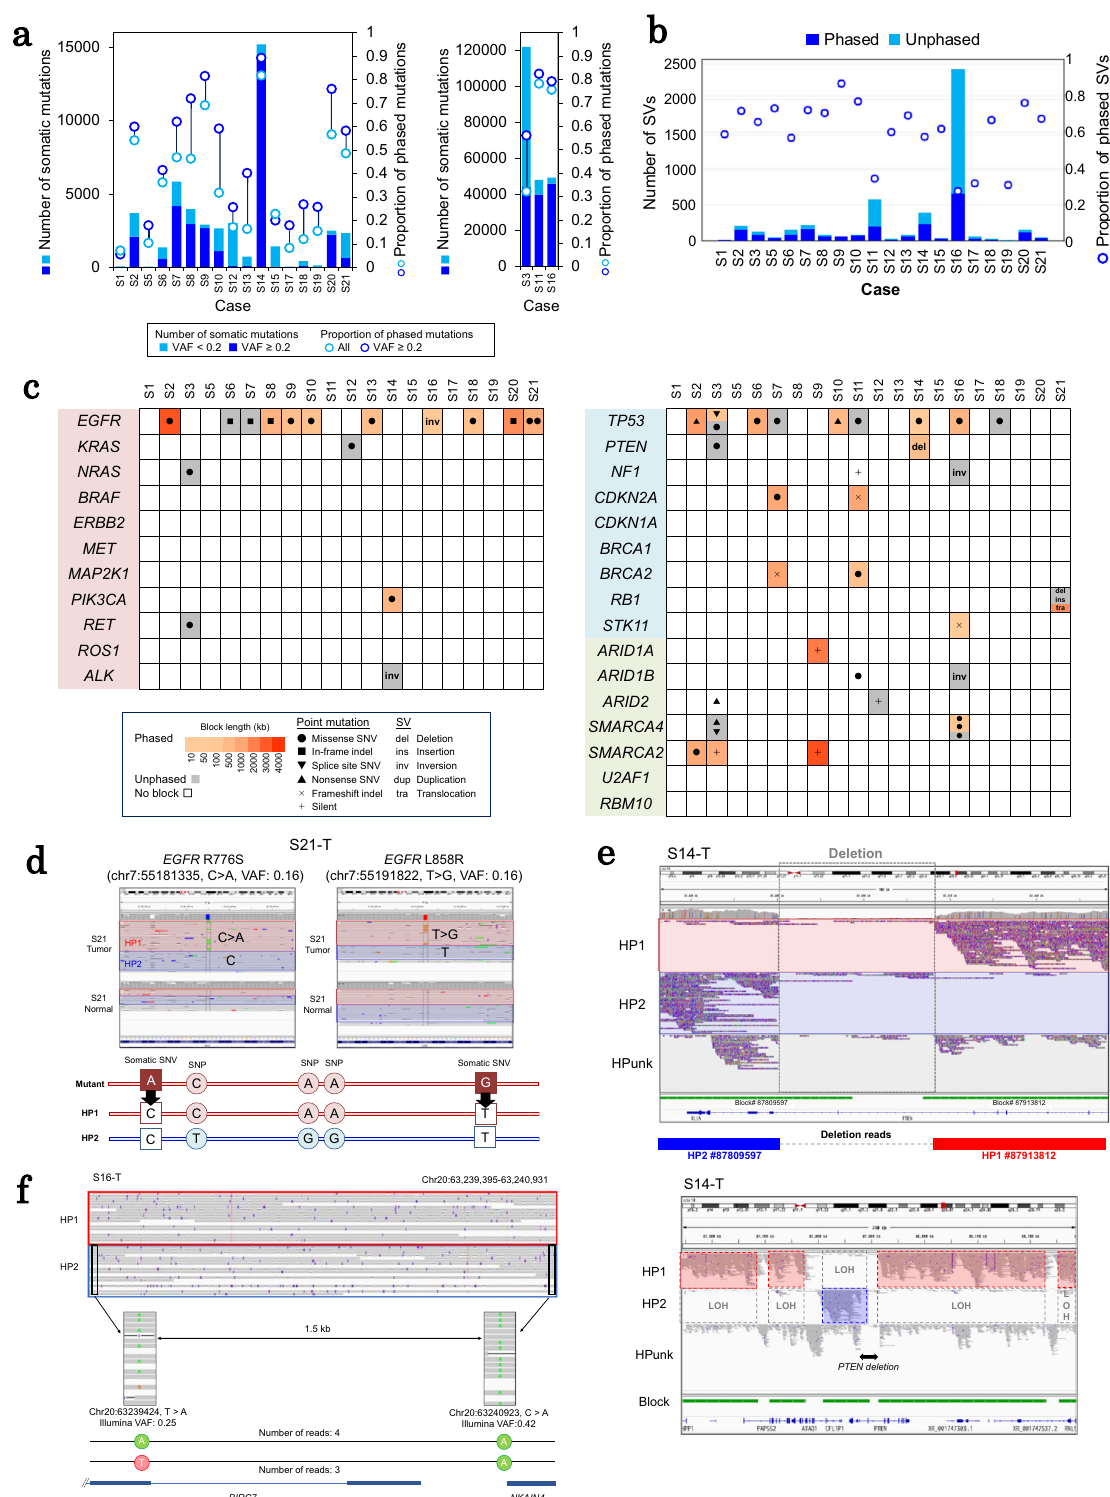
transcriptions in cancers 18 . At the genomic level, 33,820 reg- ulatory mutation candidates were located in either the promoter or enhancer regions according to previous studies 23 , and they were covered by the phased blocks in this study. Overall, an average of 32% and 37% of such regulatory mutation candidates resided in the promoter and enhancer regions, respectively, and were assigned to either of the haplotypes (Supplementary NATURE COMMUNICATIONS| (2022) 13:3464